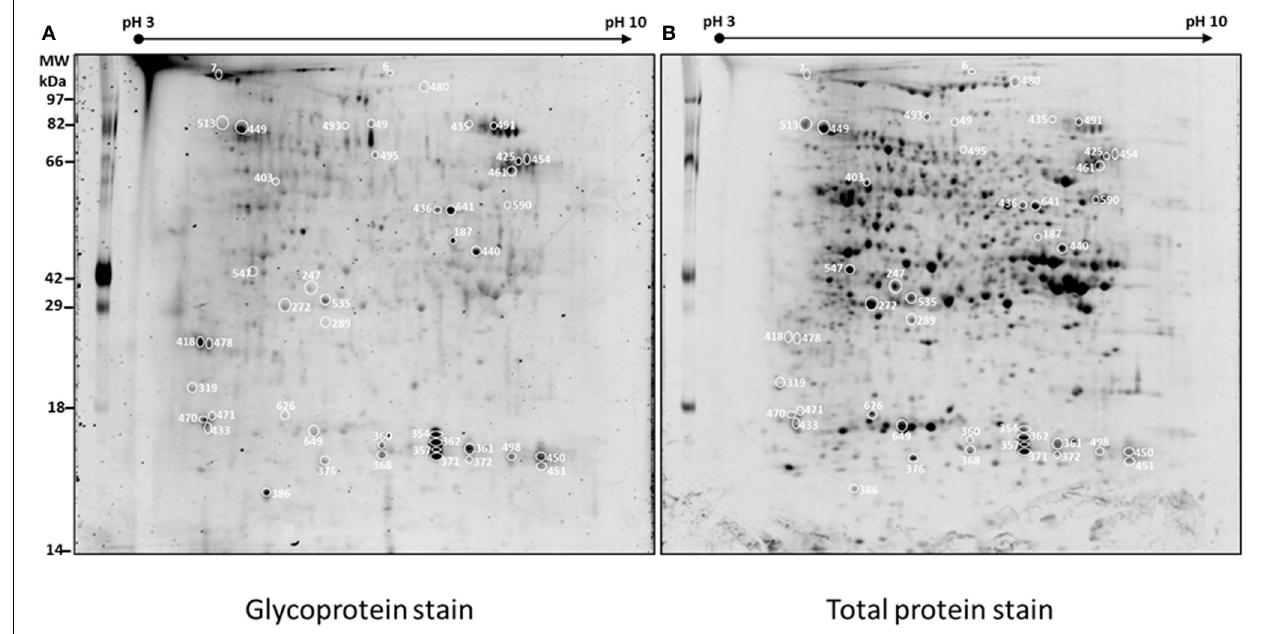
FIGURE 1 | Representative 2D-PAGE of BETL total protein extract stained with ProQ emerald for glycoprotein detection (A) and Sypro ruby for total protein detection (B). The spots along with the spot